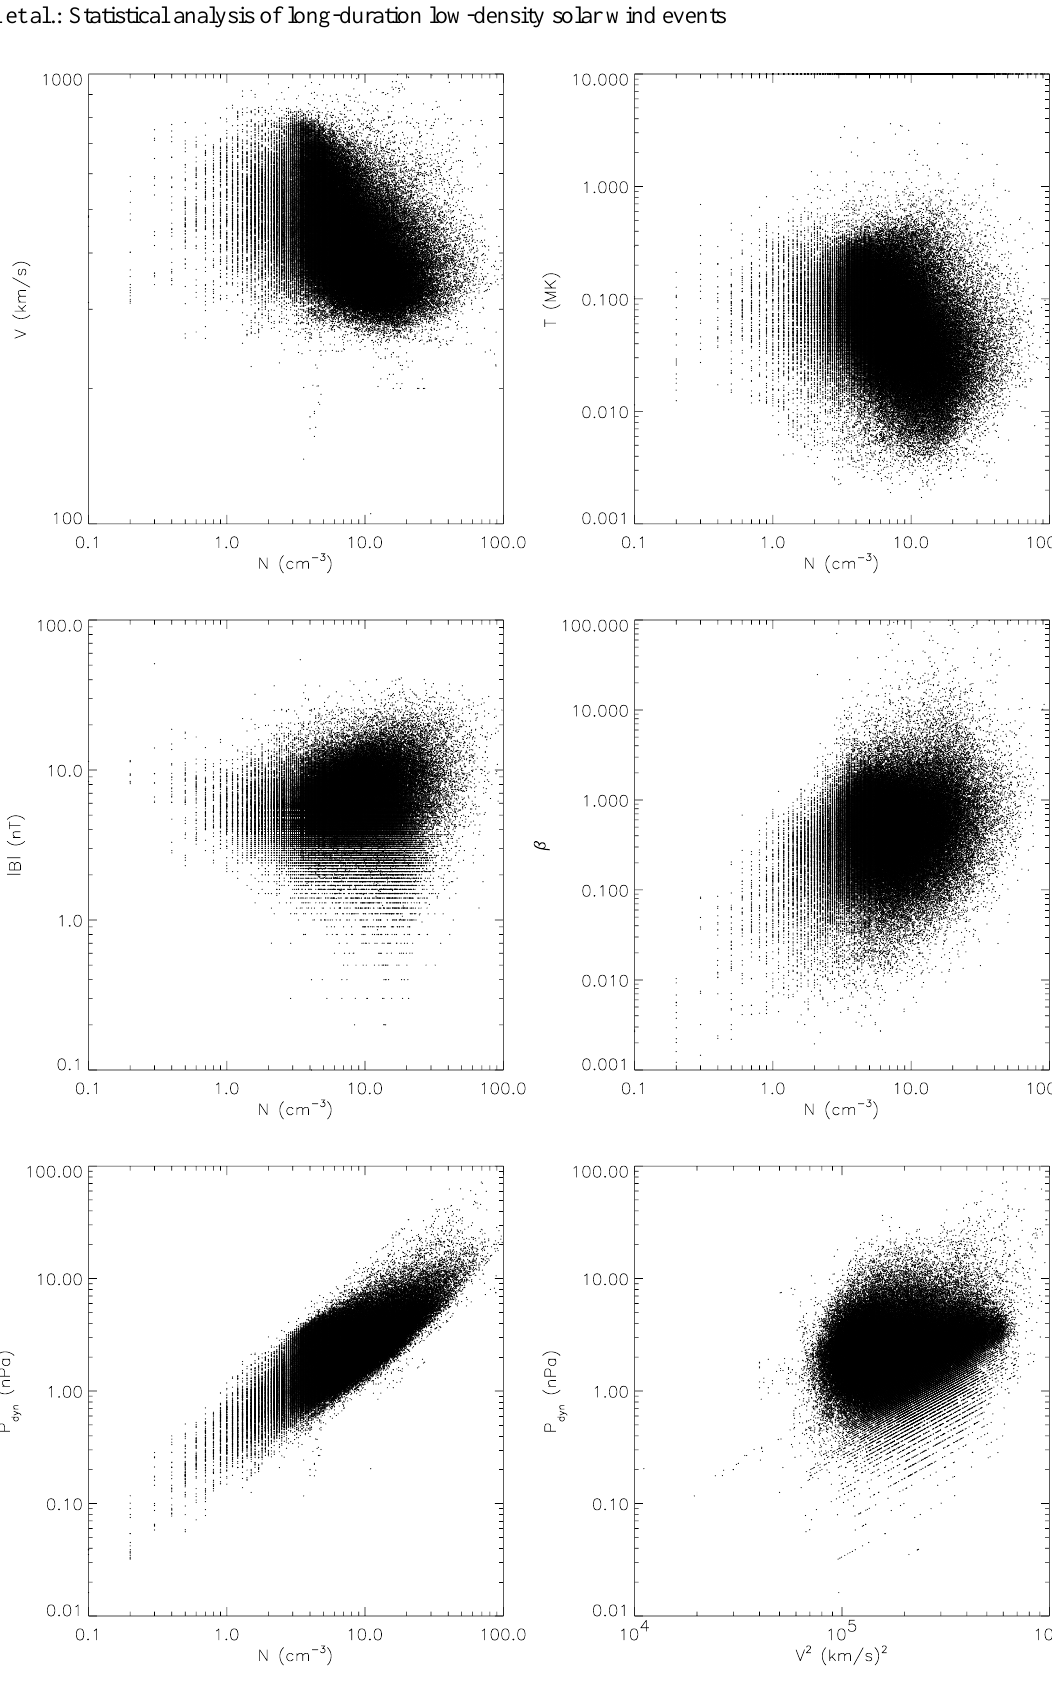
Fig. 5. Scatter plots of density ( N ) vs. speed ( V ), N vs. temperature ( T ), N vs. magnetic field intensity ( | B | ), N vs. plasma beta ( β ), N vs. dynamic pressure ( P dyn ), and square of speed ( V 2 ) vs. P dyn